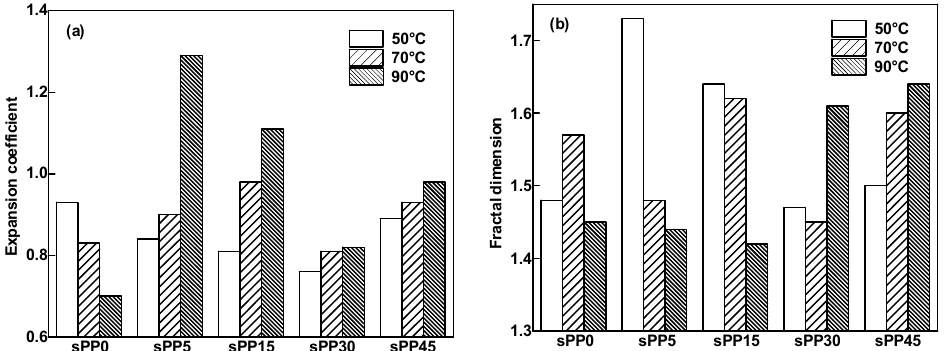
Figure 5. Expansion coefficient and fractal dimension of electrical tree in iPP/sPP blends at 50, 70, and 90 °C under AC voltage of 6 kV for 40 min. ( a ) Expansion coefficient, ( b ) Fractal dimension.